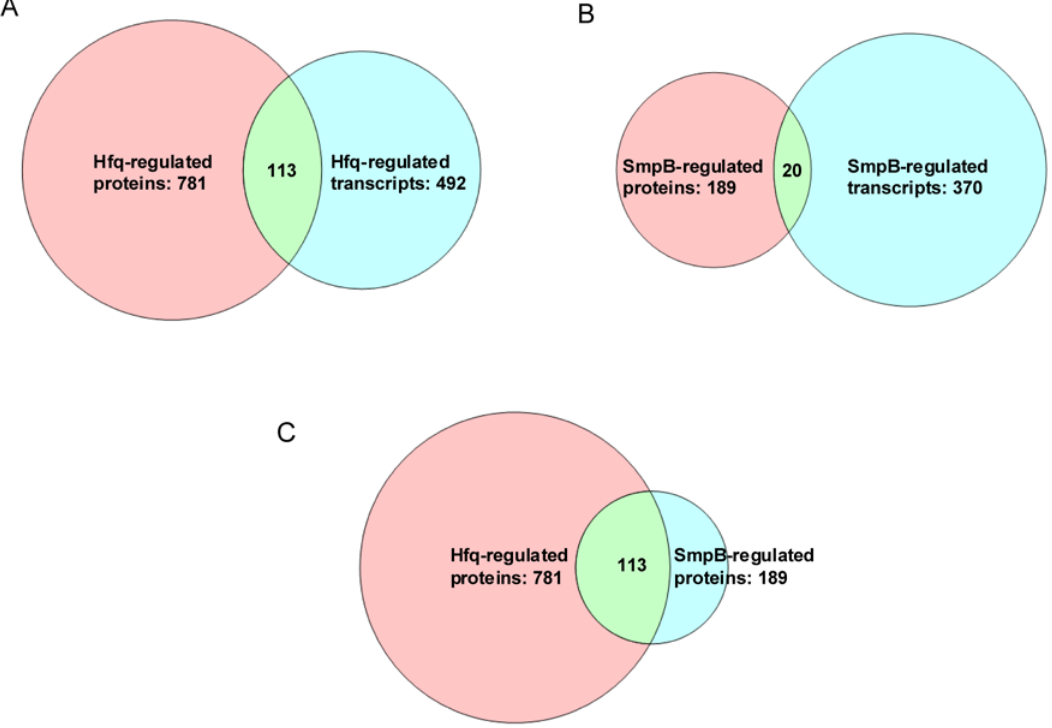
Figure 3. Summary of transcriptional and translational control functions of Hfq and SmpB. Venn diagram showing overlap between transcripts and proteins regulated by Hfq (Panel A), between transcripts and proteins regulated by SmpB (Panel B) and between proteins co- regulated by Hfq and SmpB (Panel C) across all growth conditions.